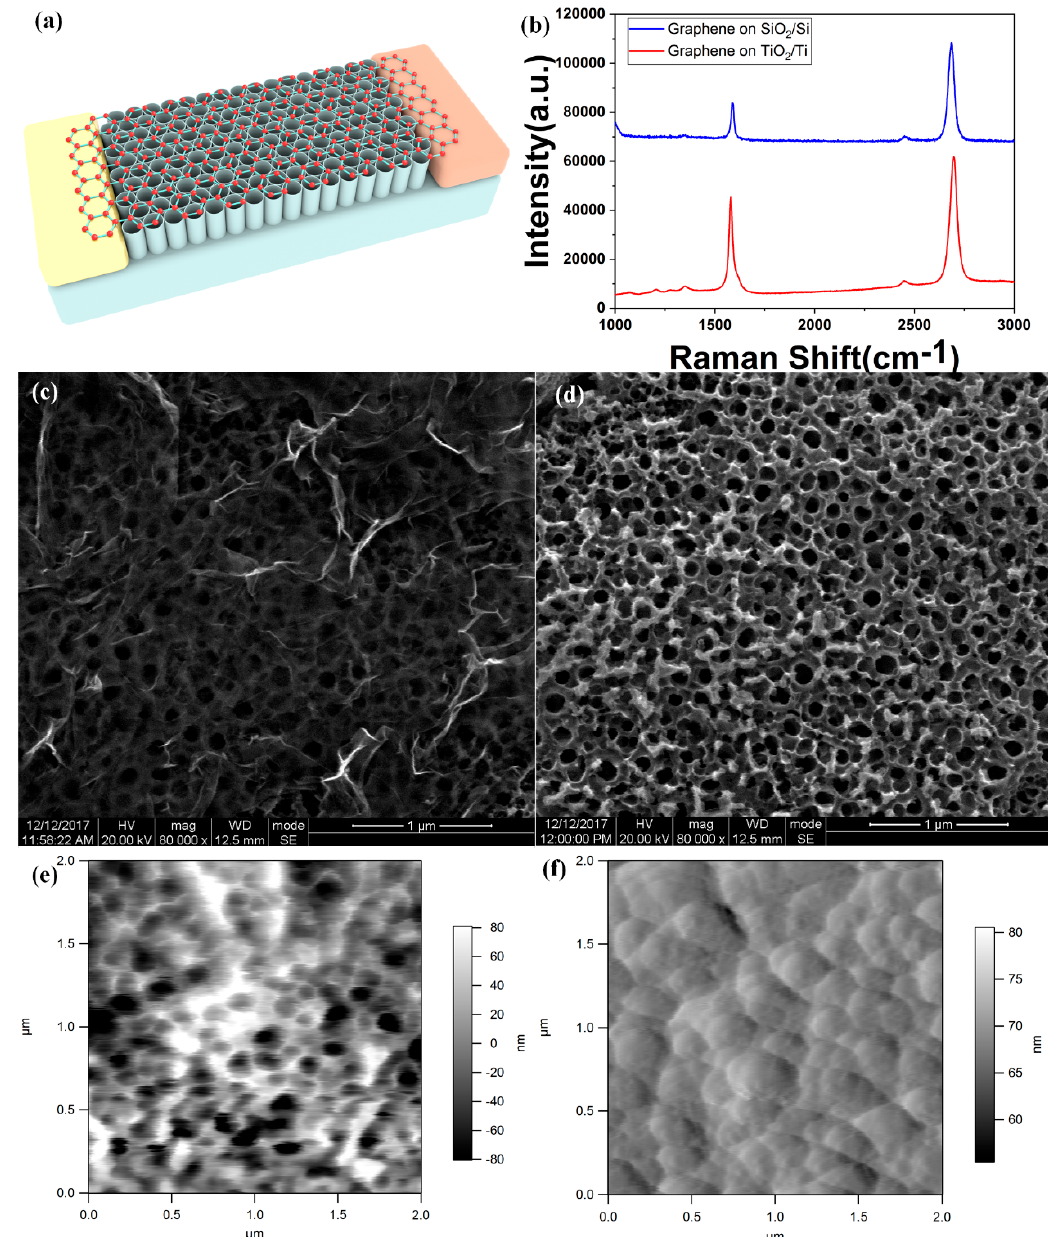
Figure 1. ( a ) Structural schematic of the graphene-TiO 2 nanotubes heterojunction photodetector. ( b ) Raman shift spectrum of the graphene transferred on the TiO 2 nanotube and Si/SiO 2 substrate. ( c ) SEM image of the graphene transferred on the TiO 2 nanotube. ( d ) Top view of the TiO 2 nanotube before coating gold by SEM. ( e ) AFM(atomic force microscopy) of the TiO 2 nanotubes. ( f ) AFM of the gold layer on the TiO 2 nanotubes.